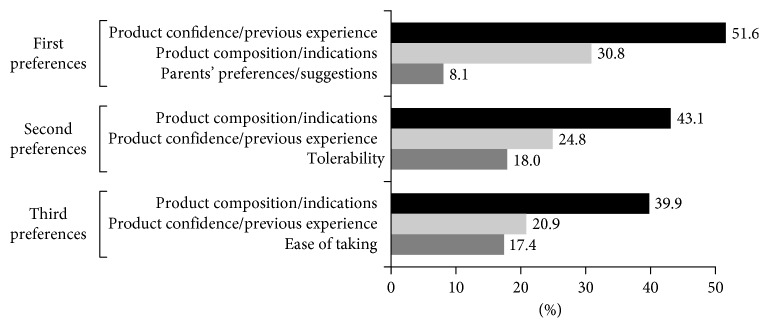
Factors taken into account at the time of recommending a dietary supplement by order of preferences.